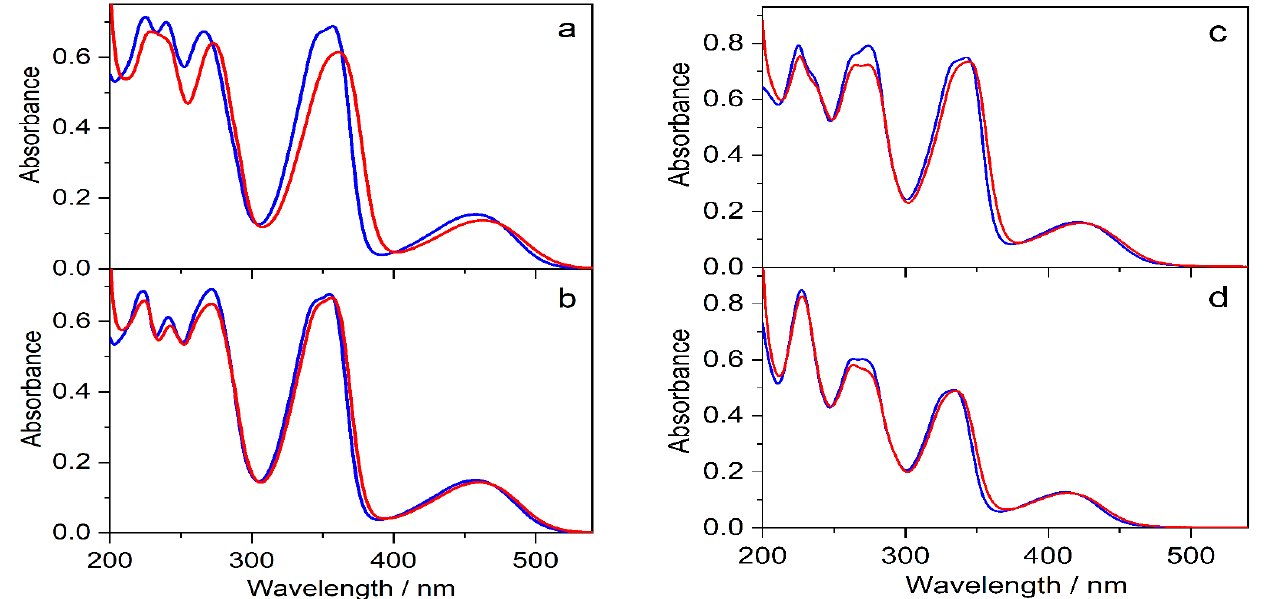
Figure 7. Absorption spectra of ( a ) 31 μ M C, ( b ) 28 μ M E, ( c ) 30 μ M P, and ( d ) 22 μ M DHC aqueous solutions (blue lines) and after the addition of 10 mM SBE 6.4 β CD (red lines) in quartz cuvette of 10 mm optical path.